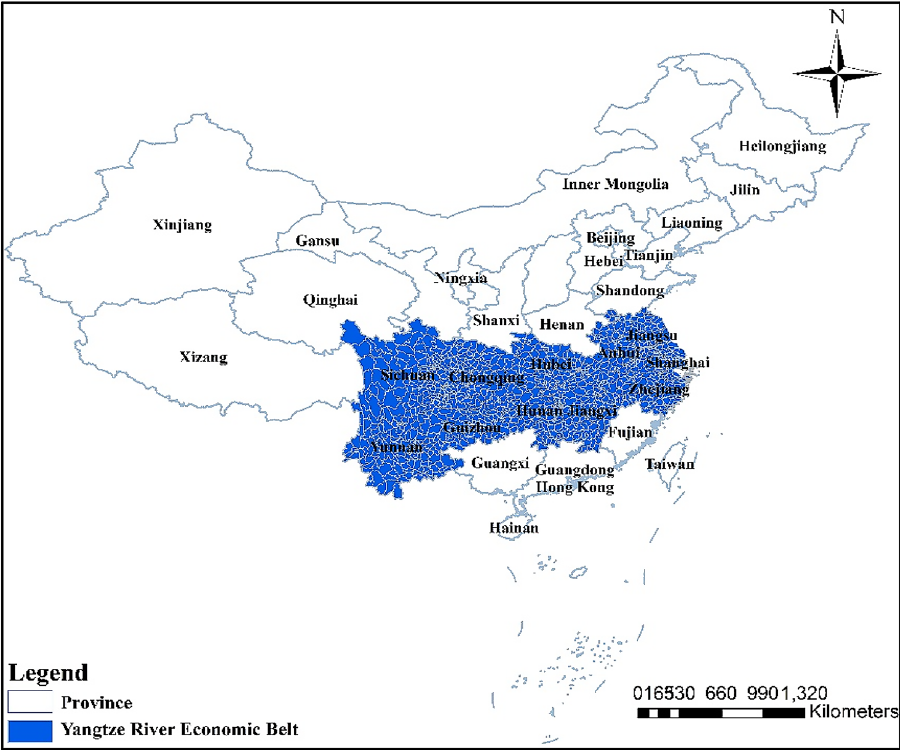
Figure 1. Location of the Yangtze River Economic Belt in China. Map is produced using ArcGIS 10.2 (http:// www. esri. com/ softw are/ arcgis/ arcgis- for- deskt